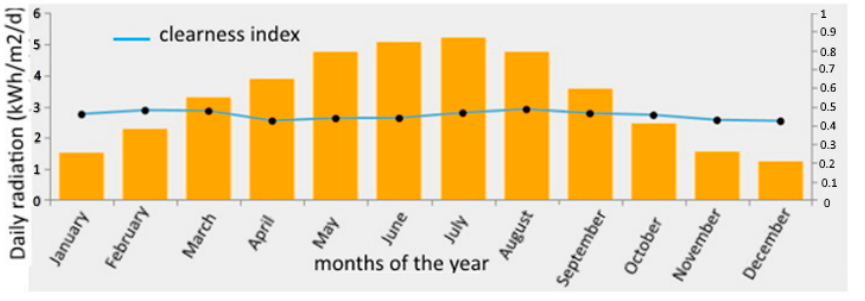
Figure 3. Solar irradiation data.